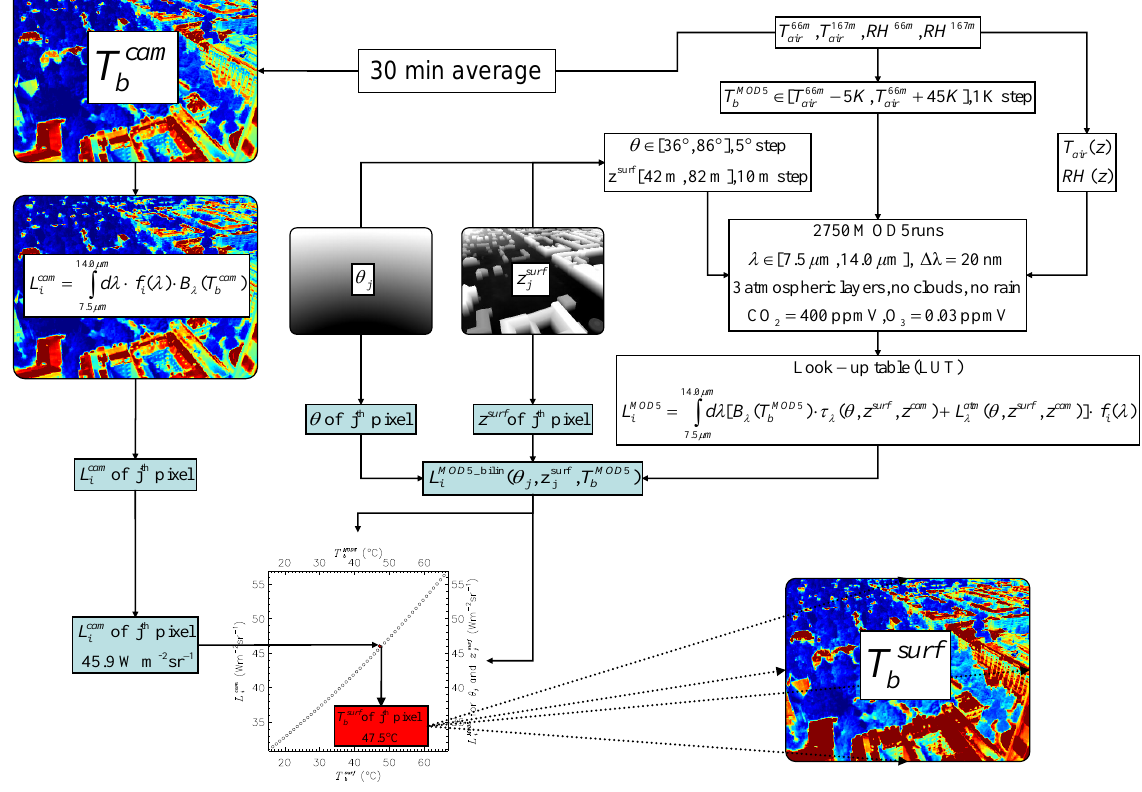
Fig. 4. Flowchart of the multi line-of-sight (MLOS) method on a pixel-by-pixel basis for correction of atmospheric effects in off-nadir TIR imagery acquired in an urban environment.